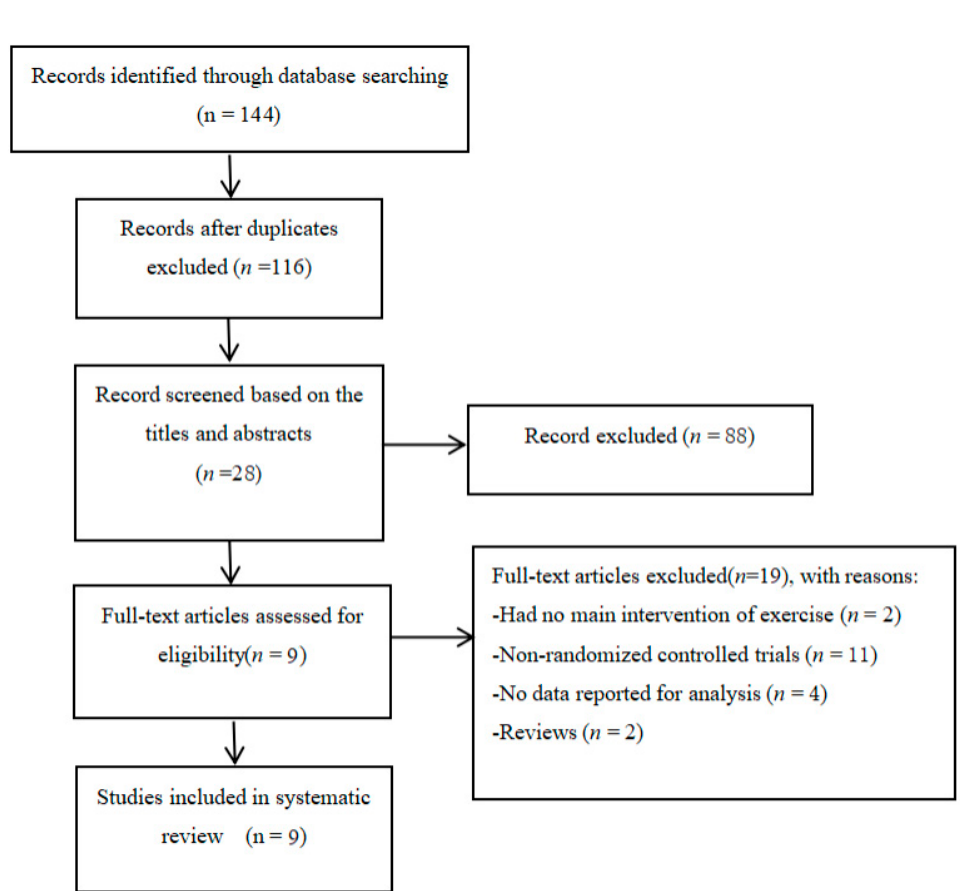
Figure 1. Flow of study selection.